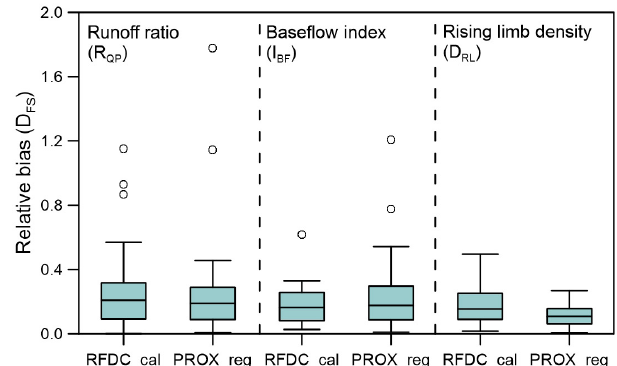
Figure 8. Flow signature reproducibility comparison between RFDC_cal and PROX_reg in terms of R QP (a) , I BF (b) , and D RL (c)